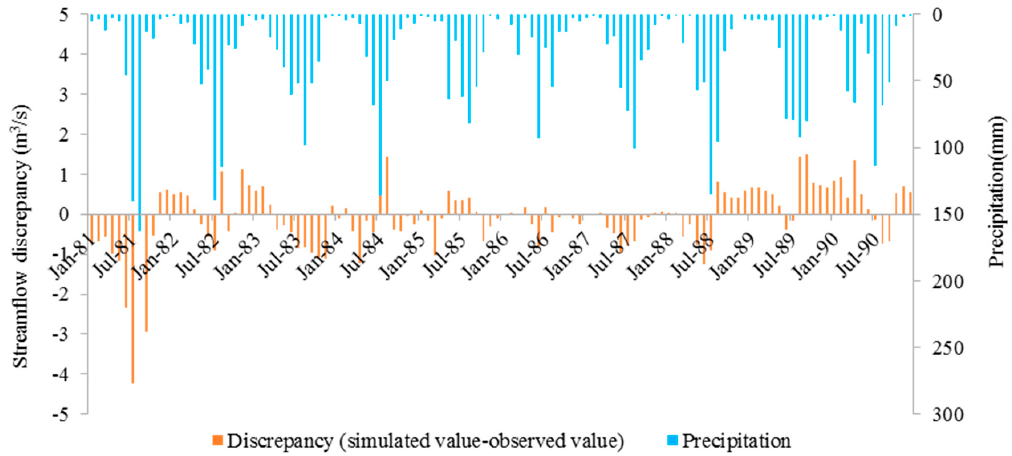
Figure 5. The discrepancy between the simulated and observed streamflow values under Scenario 0 in the USK river basin.